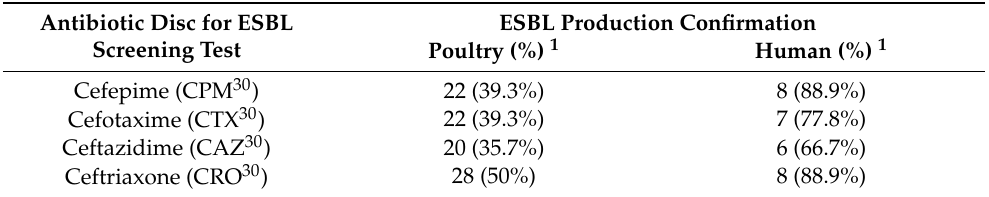
Table 4. ESBL disc confirmation by the Double Disc SynergyTest (DDST). The confirmation was considered positive if the cephalosporin inhibition zone was extended toward the clavulanic acid antibiotic.